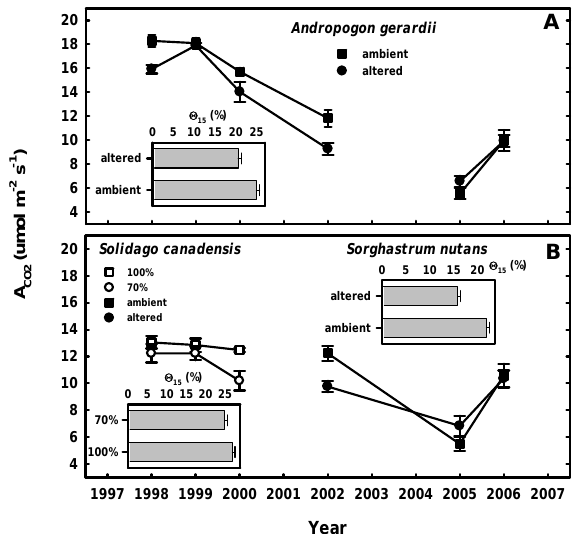
Fig. 6. Leaf photosynthesis ( A CO ) by rainfall treatment for (A) 2 Andropogon gerardii (C 4 ) and (B) Sorghastrum nutans (C 4 ), and Solidago canadensis (C 3 ). Insets: mean 0–15cm volumetric soil water content ( 2 15 ) for years when altered rainfall caused signifi- cant reductions in A CO . Error bars denote 1SE of the 2